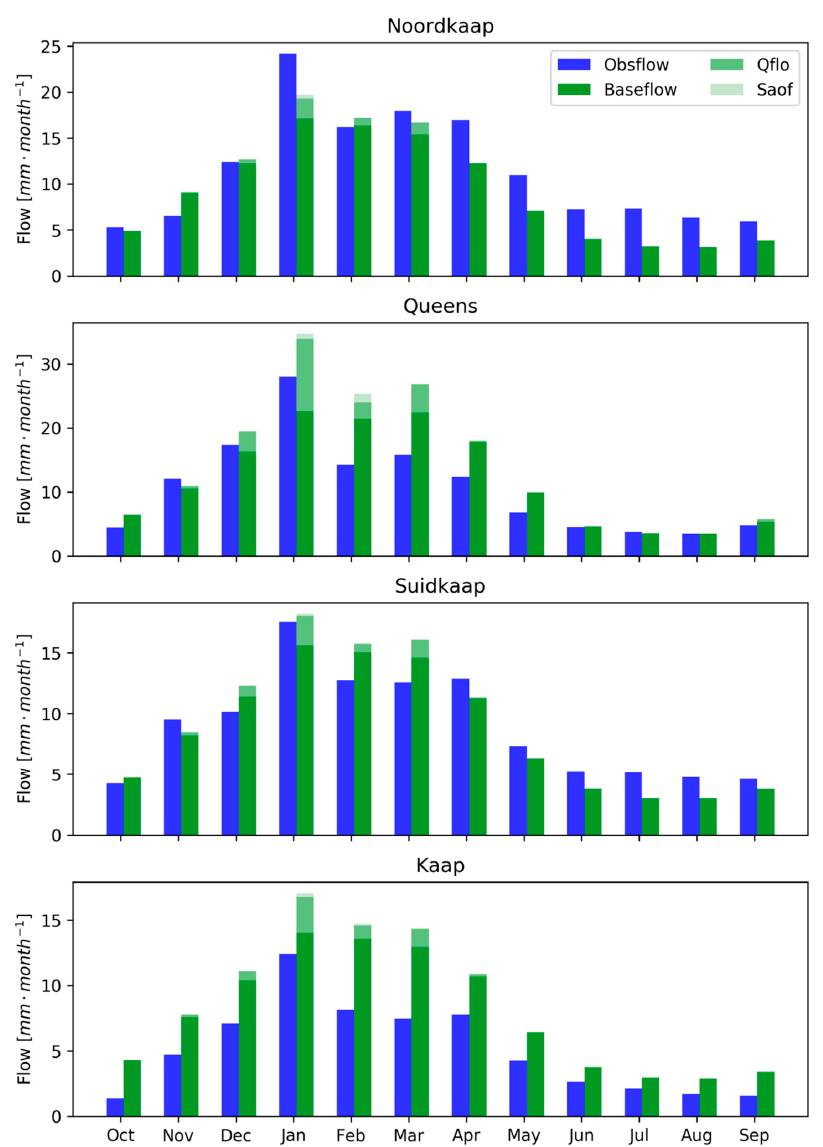
Figure 6. Mean monthly observed and modelled flow for the four catchments, using results of run 64. Modelled flow is partitioned in the components: baseflow, saturated overland flow (Saof) and quickflow component (Qflo).